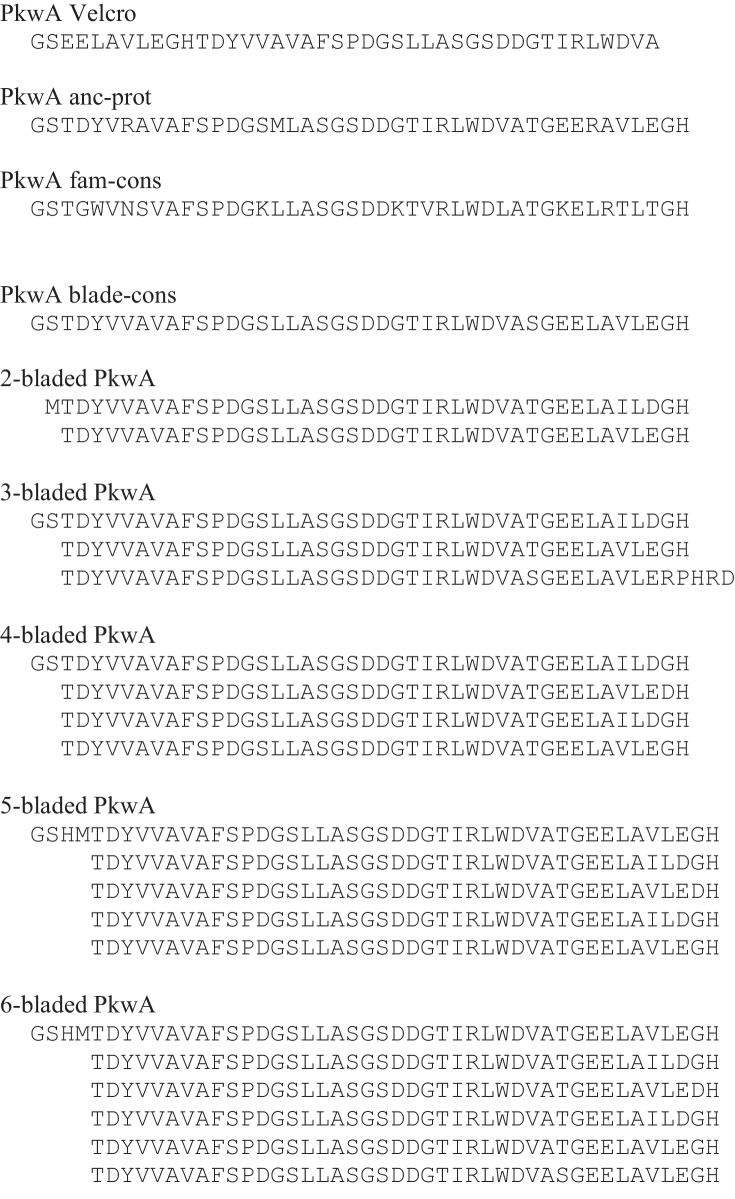
Sequences of PkwA constructs.Due to the thrombin cleavage site motif, all PkwA proteins originally expressed as GST-fusions start with an additional GS and proteins expressed with a His6-tag start with GSHM.